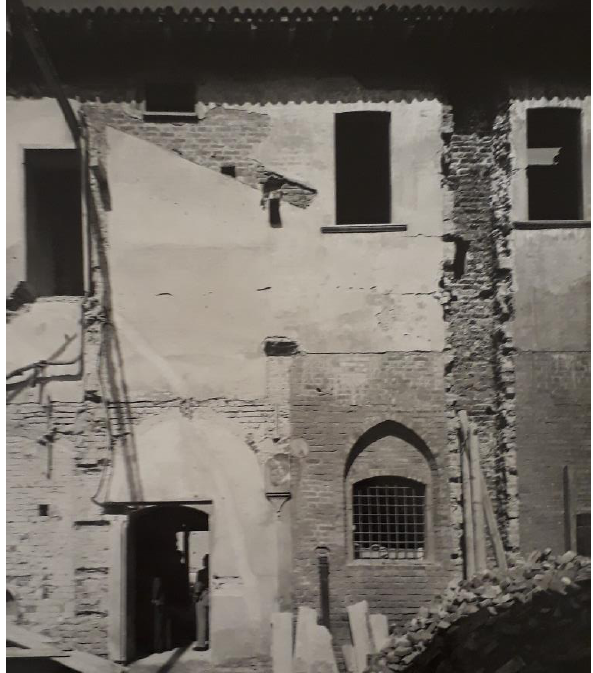
Figure 2. Space between the New Sacristy and the Cloister of the Prior, demolished after II World War to enlarge the New Sacristy and renew the layout of the